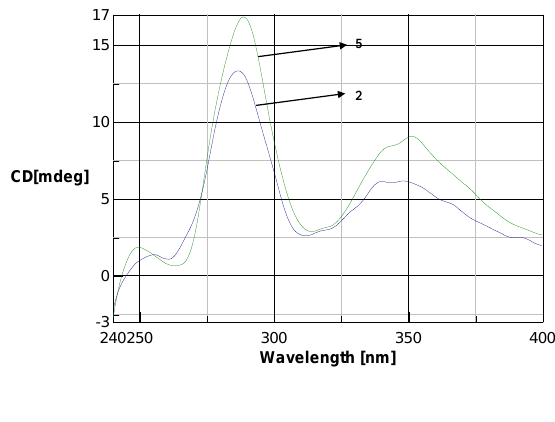
Figure 2. CD spectra of compounds 5 and its aglycone 2 .